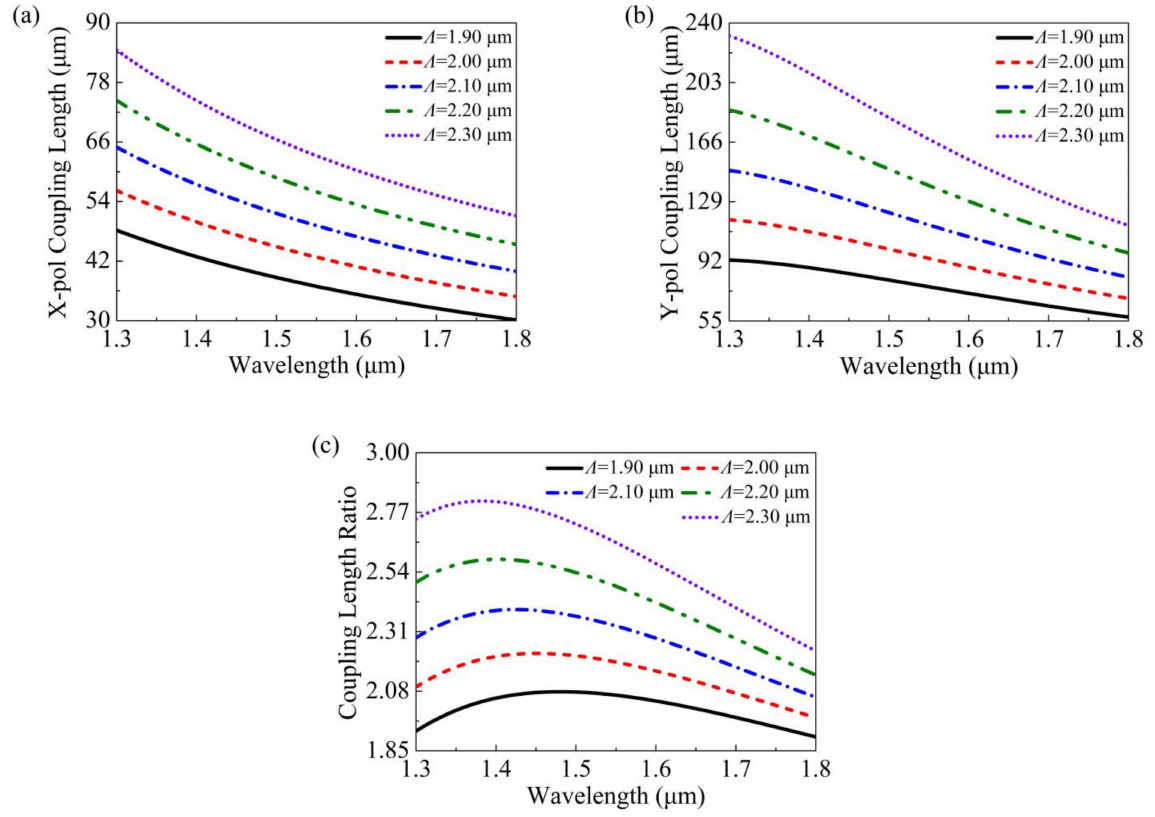
Figure 11. The change rules of the ( a ) CL X , ( b ) CL Y , and ( c ) CLR of the LC-DC-PCF with wavelengths for different Λ